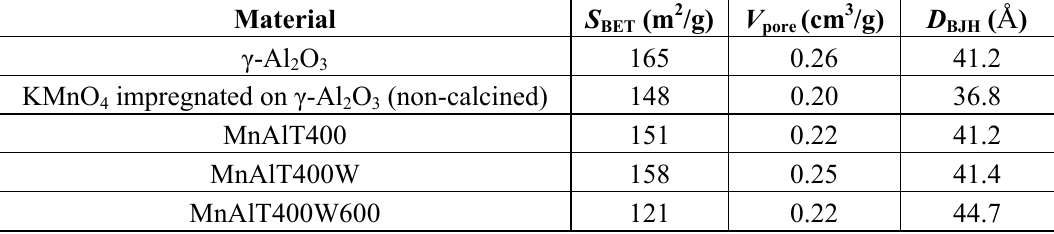
) and average pore diameter ( D pore